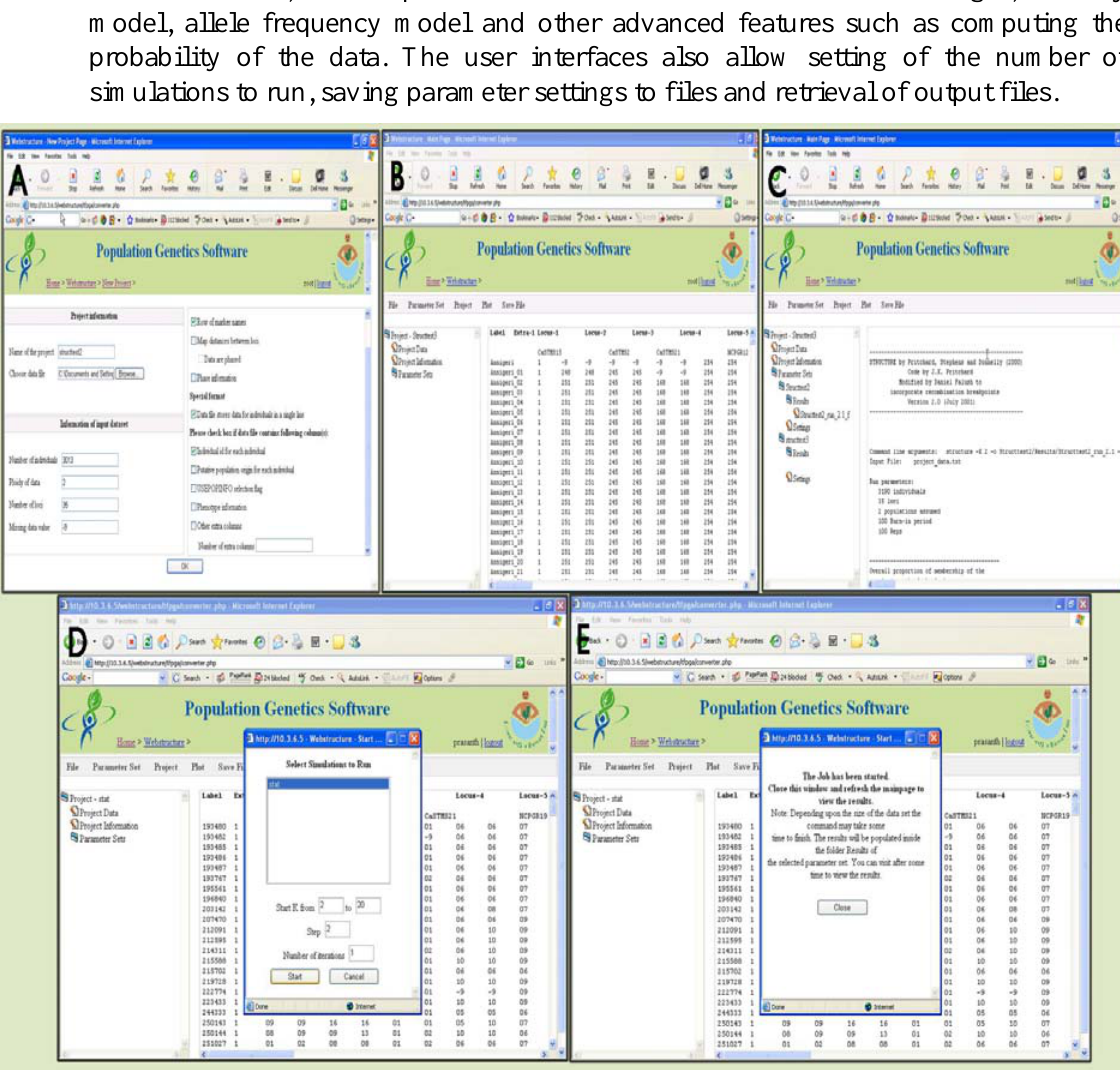
Figure 1: WebStructure interfaces (A) entering input file information (B) setting Structure parameters (C) invoking the Structure program (D) setting number of simulations and (E) executing a